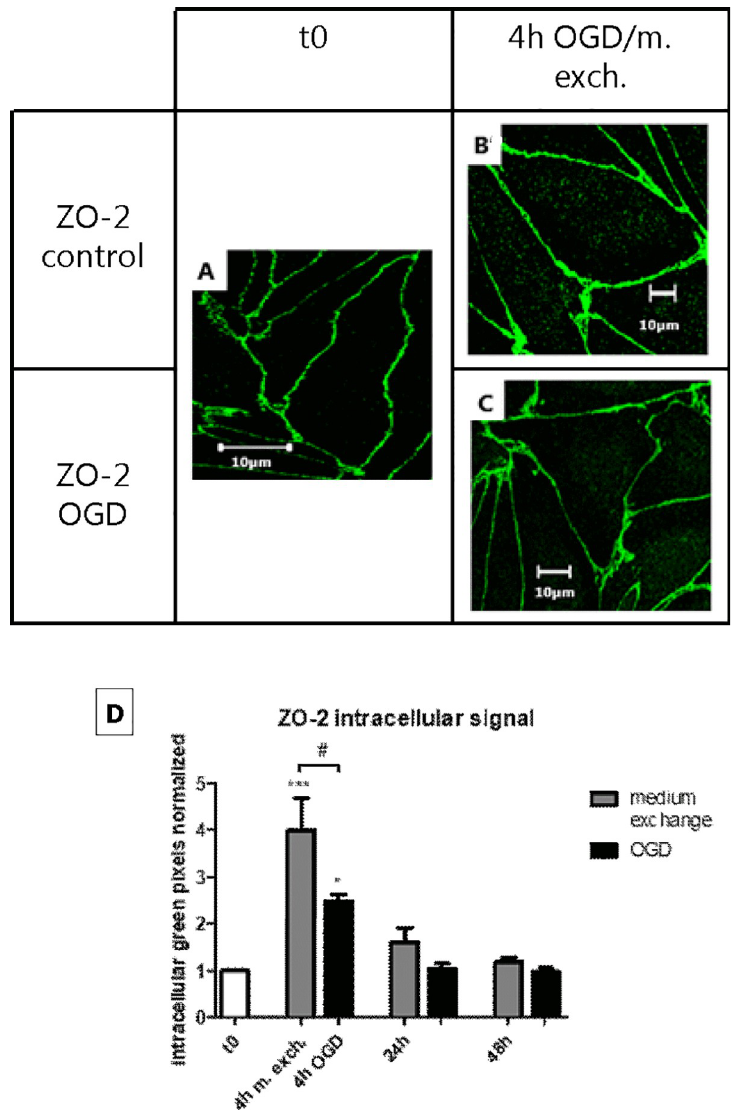
Fig 4. Cellular localization of ZO-2 along the oxygen-glucose deprivation (OGD) and medium exchange protocols. Endothelial cells in co-culture with astrocytes treated with OGD or medium exchange and reperfused for 24/48 h, were fixed and stained with an antibody anti-ZO-2. Fig A shows the localization of ZO-2 before the treatments (t0), Fig B shows the localization of ZO-2 after 4 h from medium exchange, and Fig C shows the localization of ZO-2, 4 h after OGD. Bars = 10 μ m. N = 1; n = 3. (D) For each condition, the intracellular signal intensity was estimated using ImageJ as described in the “Materials and methods” section. Bar graphs represent means normalized to t0 and error bars are +SEM. (N = 9–12, n = 3–4). The white bar shows the value at t0, the gray bars show the cells subjected to medium exchange, while the black bars show the OGD treated cells. Columns were compared to t0 using one-way ANOVA and Dunnett’s multiple comparison post-test. � : p < 0.05, ��� : p < 0.001. Bonferroni’s post-test was utilized to compare each pair of columns. #: p < 0.05. As judged by immunolabelling and confocal laser microscopy analysis, GLUT-1 appeared to be localized mainly in the cytosol at t0, after 4 h of OGD and medium exchange and at 48 h of reperfusion following both the OGD and the medium exchange treatments. At 24 h of reperfusion, a slight up-concentration at the cell border was detected in both the OGD- and medium exchange-treated cells (Fig 7A–7G). The receptor HB-EGF had a perinuclear staining